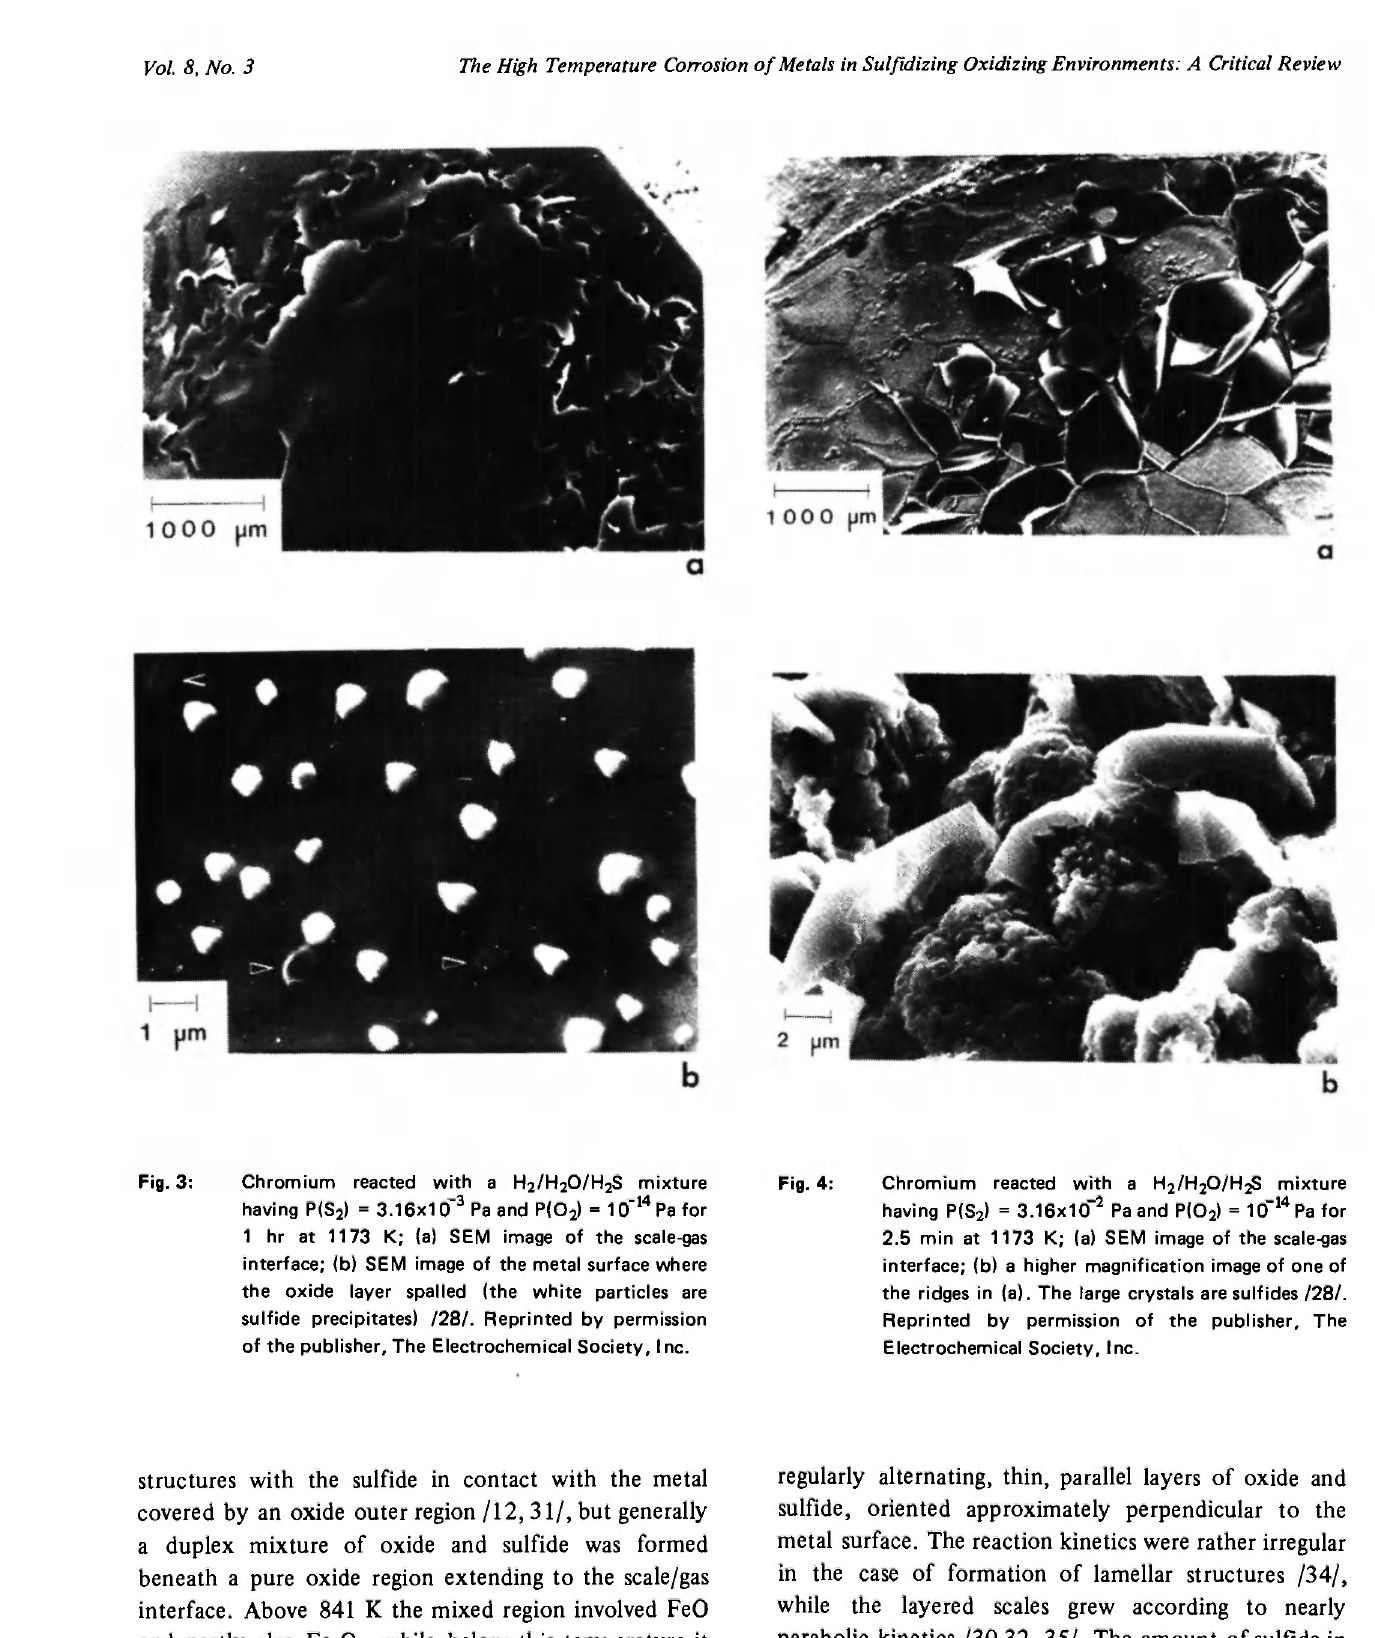
Fig. 3: Chromium reacted with a H2/H2O/H2S mixture having P(S 2 ) = 3.16x10~ 3 Pa and P(0 2 ) = 10" l4 Pa for 1 hr at 1173 K; (a) SEM image of the scale-gas interface; (b) SEM image of the metal surface where the oxide layer spalled (the white particles are sulfide precipitates) /28/. Reprinted by permission of the publisher. The Electrochemical Society, Inc.